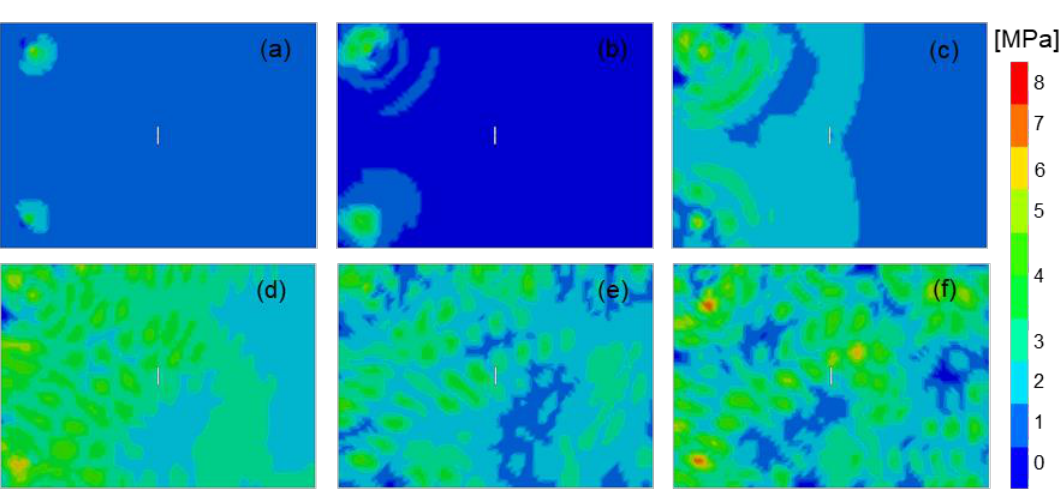
Figure 6. Wave propagation: ( a ) t = 2,4e −09 s; ( b ) t = 6,8e −09 s; ( c ) t = 1,2e −08 s; ( d ) t = 3,6e −08 s; ( e ) t = 5,3e −08 s; ( f ) t = 1,1e −07 s.